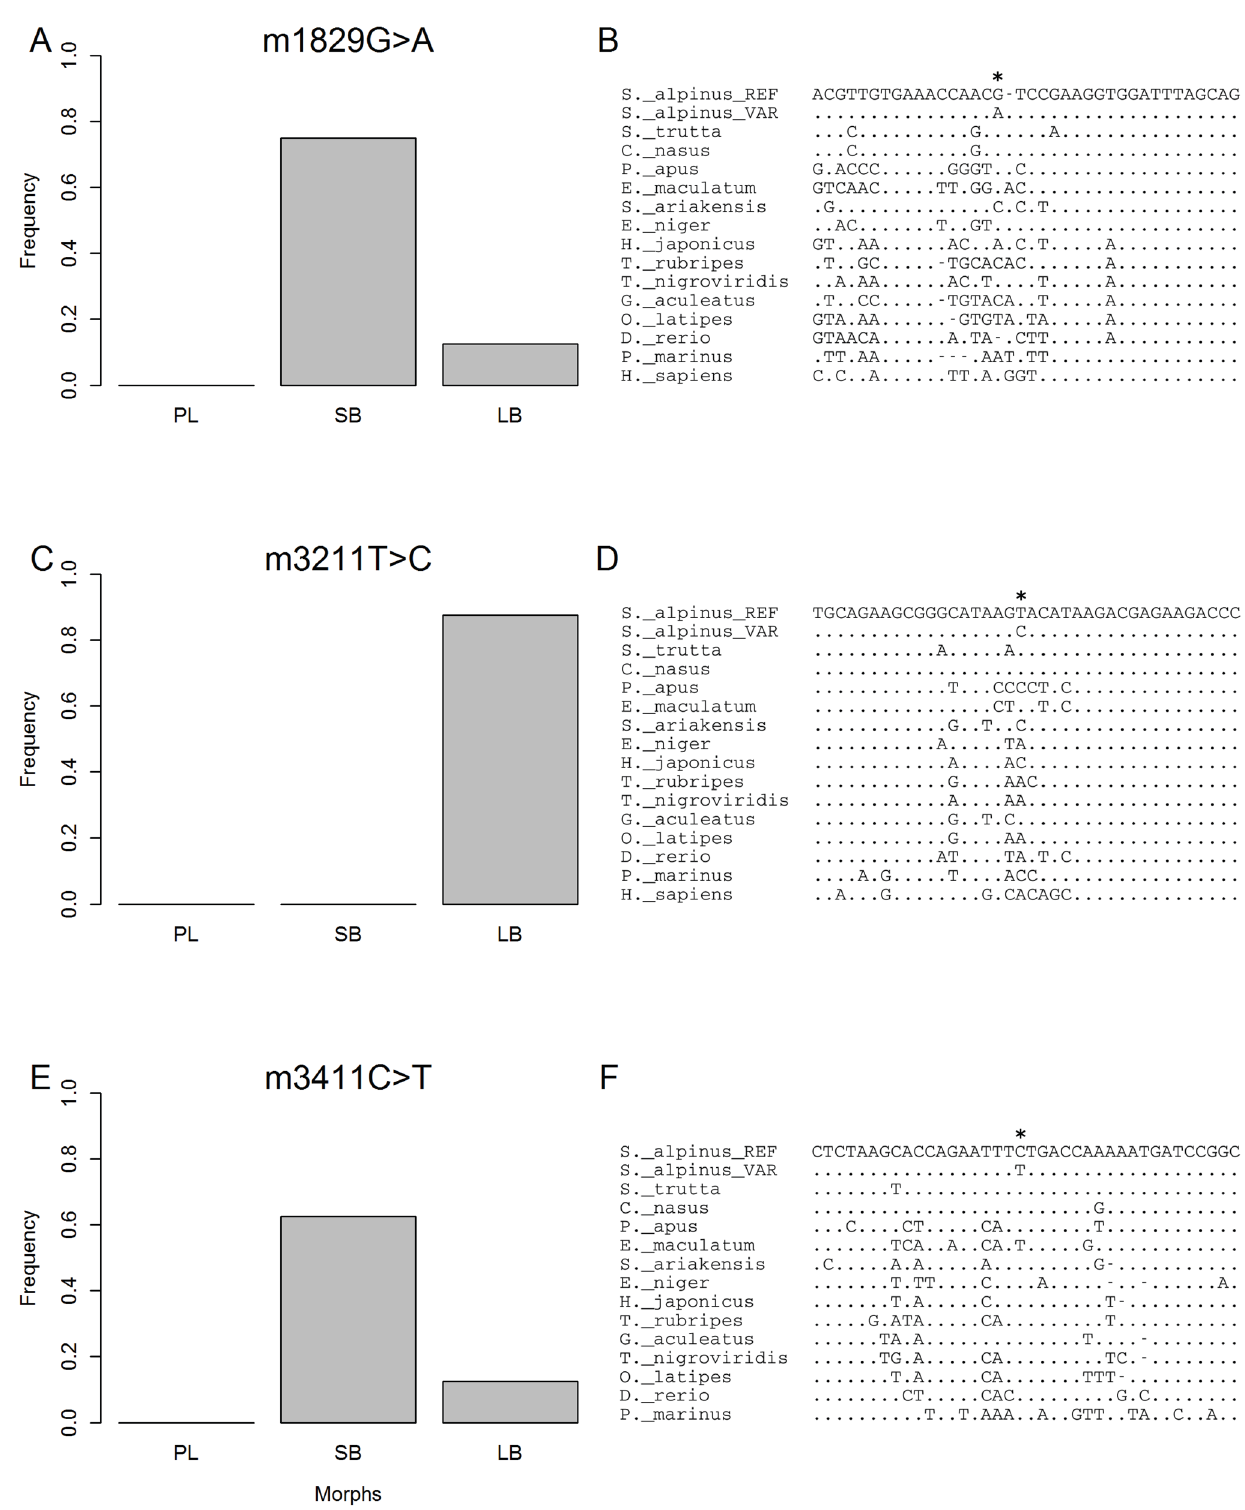
Figure 8. Comparative genomics and population genetic differentiation in Arctic charr at 3 mtDNA locations. Three variants in the 12s and 16s RNA genes are segregating in charr morphs in Lake Thingvallavatn. A , C , E ) Frequency of each of those variants in three morphs from Lake Thingvallavatn (PL, LB and SB). A total of 8 individuals were genotyped from each morph, see methods. B , D , F ) Aligned are several fish genomes, with Lamprey or humans as outgroups, reflecting a 38 bp window around each of the 3 positions (). Indicated are the two Arctic charr alleles, the reference allele (S._alpinus_REFcharr_WT) and the derived variant (S._alpinus_VARcharr_M). B ) Alignment of variant m1829G>A in the 12s rRNA gene in fishes, using humans as an outgroup. D ) Similar alignment of a 16s variant, m3211T>C and F ) alignment of variant m3411C>T in the 16s rRNA